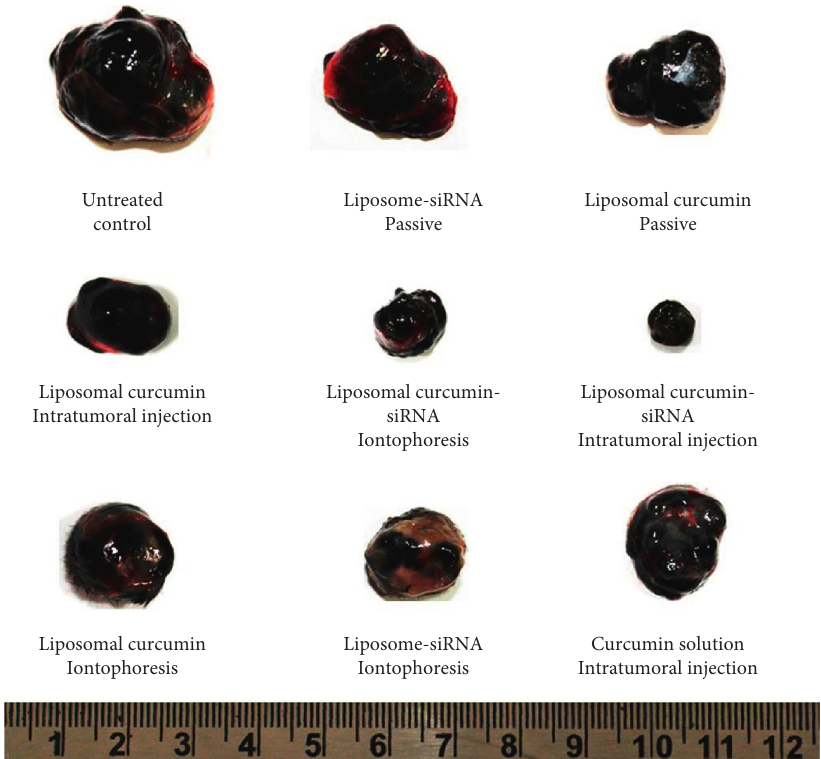
Figure 1: Tumors extracted from tumor-bearing mice after treatment with various formulations. All of the photos were of tumors isolated from five separate animals in a therapy